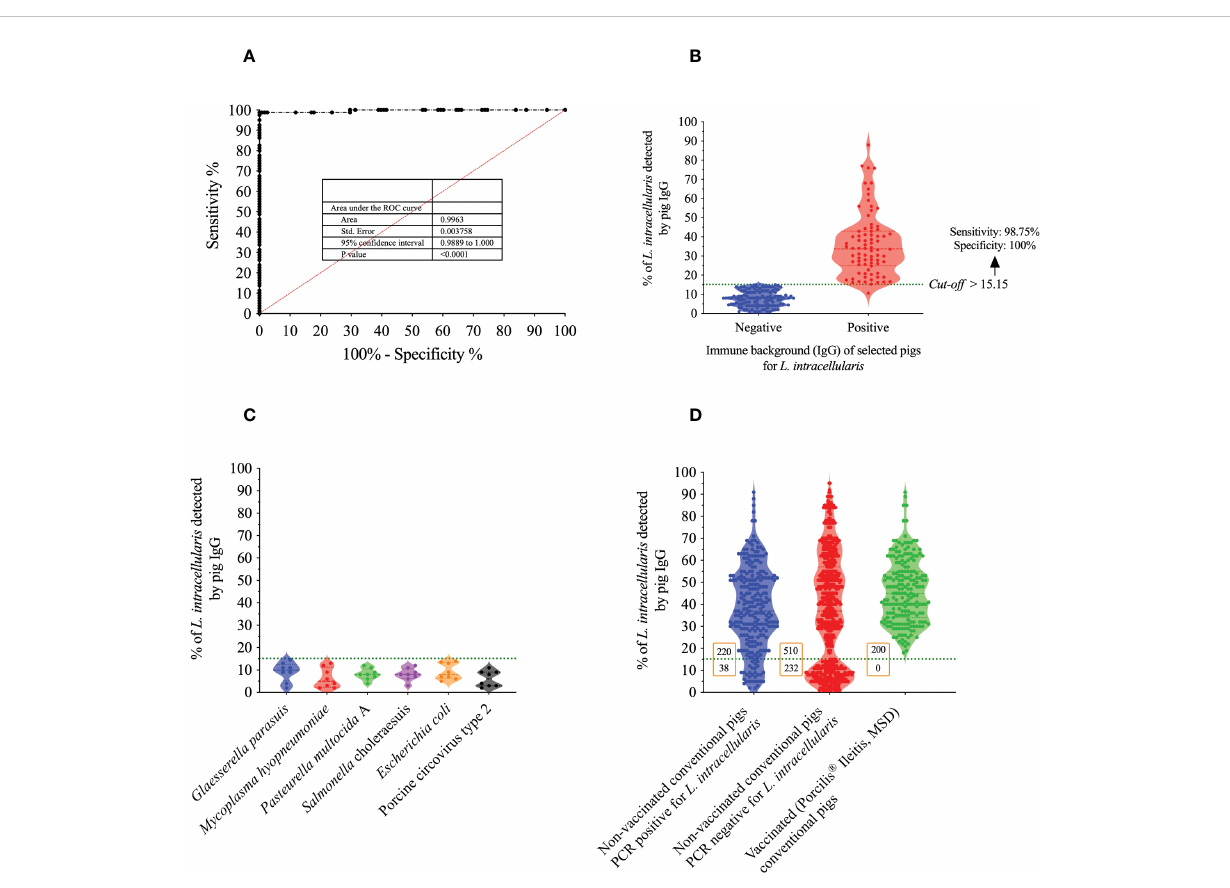
FIGURE 7 Basic immunological characteristics of the FCAT method. (A) Receiver Operating Characteristic (ROC) analysis. (B) Representation of the percentage values (dispersion) of L. intracellularis recognition of the samples used to de fi ne the cut-off of the FCAT test. The sensitivity and speci fi city of the test using the cut-off of > 15.15% are described in the fi gure. (C) FCAT speci fi city analysis using sera from pigs immunized with other pathogens. (D) Analysis of clinical samples collected from pigs with different immunological backgrounds against L. intracellularis